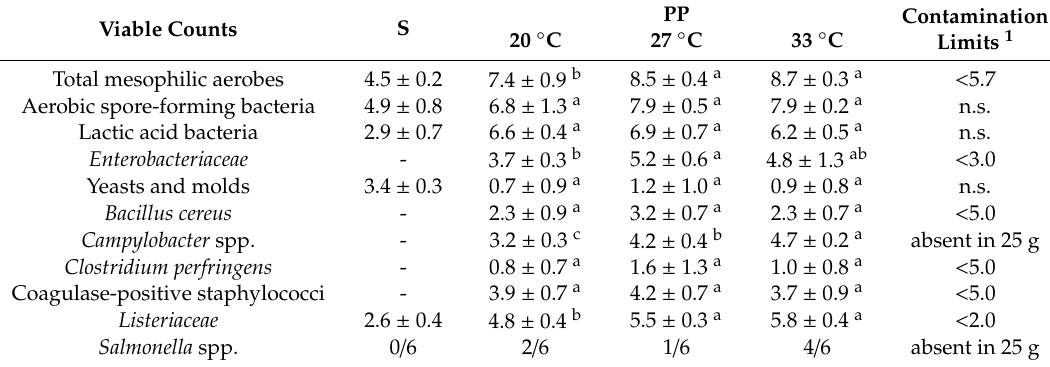
Table 2. Cultivable microorganisms observed in substrate (S) and grown prepupae (PP) grown at 20, 27 and 33 ◦ C. Counts are expressed as Log 10 CFU / g. For Salmonella spp. the number of positive samples out of six is